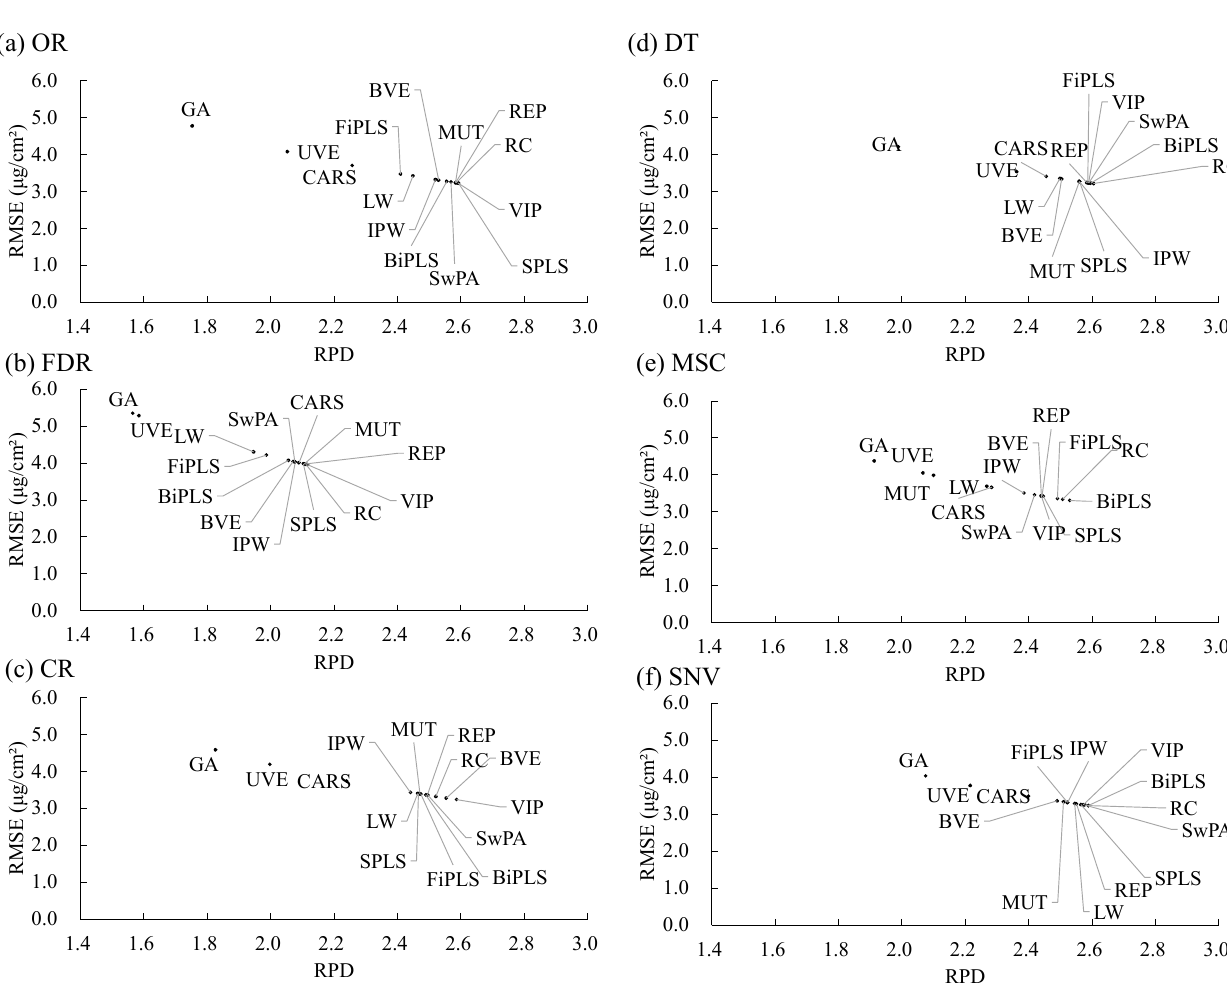
Figure 7. Relationships between the ratio of performance to deviation (RPD) and root mean square error (RMSE) for each of the preprocessing and variable selection methods tested.